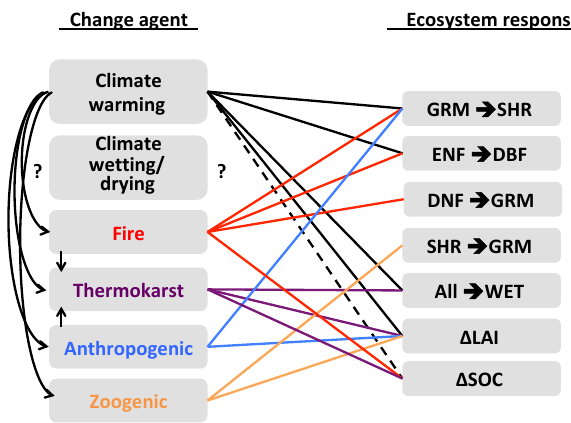
Figure 2. Summary of key drivers of ecosystem change, and the as- sociated ecosystem responses observed (solid lines) or hypothesized (dashed lines) in permafrost ecosystems. Arrows ( è ) indicate tran- sition from the current (left) to a new (right) ecosystem type, and the symbol delta ( (cid:49) ) indicates a change in the associated ecosys- tem property. Ecosystem types are defined as follows. DBF: decid- uous broadleaf forest; DNF: deciduous needleleaf forest; ENF: ev- ergreen needleleaf forest; GRM: graminoid dominated ecosystem; SHR: shrub dominated ecosystem; WET: wetland ecosystem; All: any initial ecosystem type. Ecosystem properties are as follows. LAI: leaf area index; and SOC: soil organic